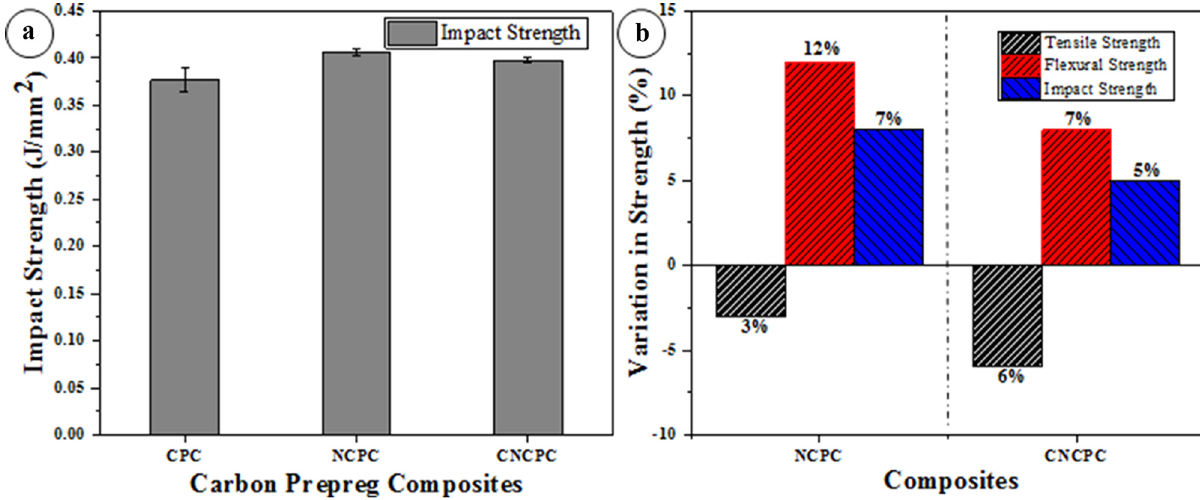
Figure 4: ( a ) Izod impact strengths of CPC, NCPC, and CNCPC composites and ( b ) % variation in mechanical properties with the addition of nano fi bers.